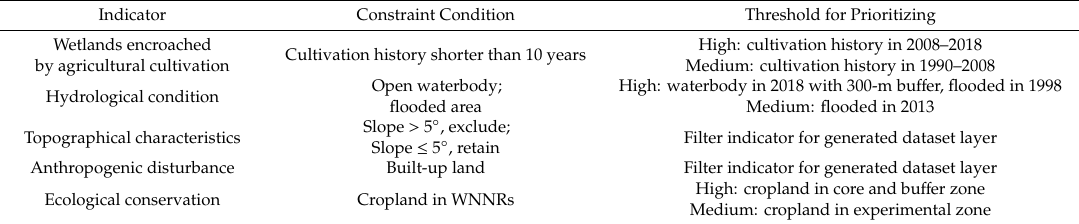
Figure 2. Framework for identifying potential wetland rehabilitation areas. Table 1. Summary for the selected five indicators for rehabilitating cropland to wetland.